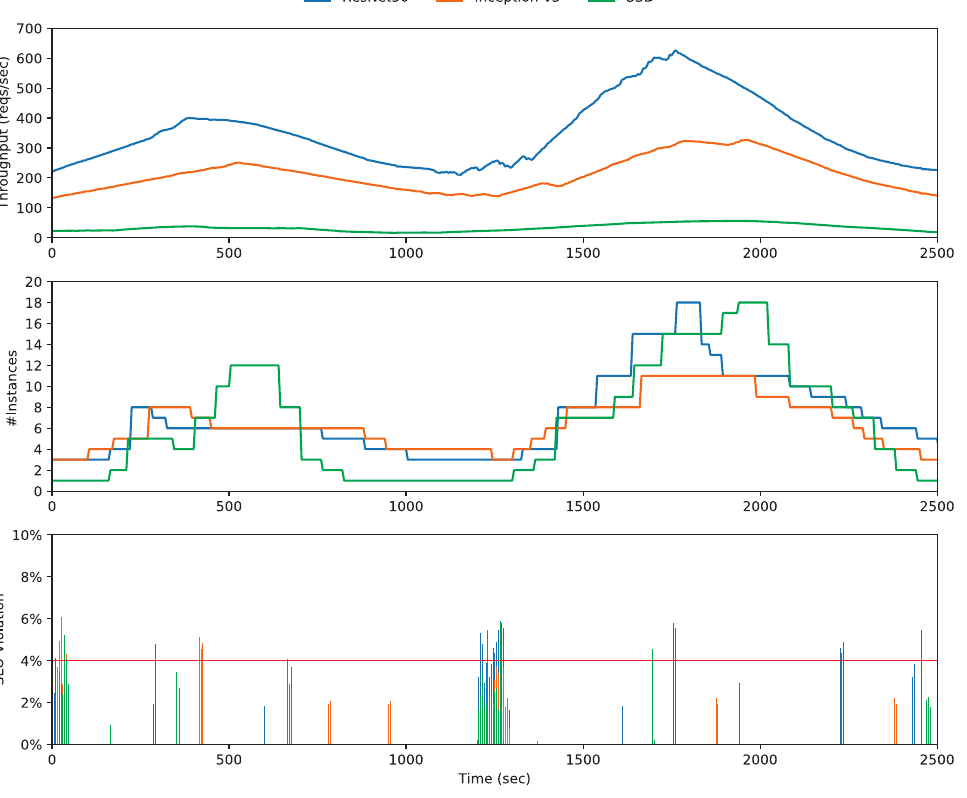
Figure 6. Throughput, number of instances and SLO violation of each model service under fluctuat- ing